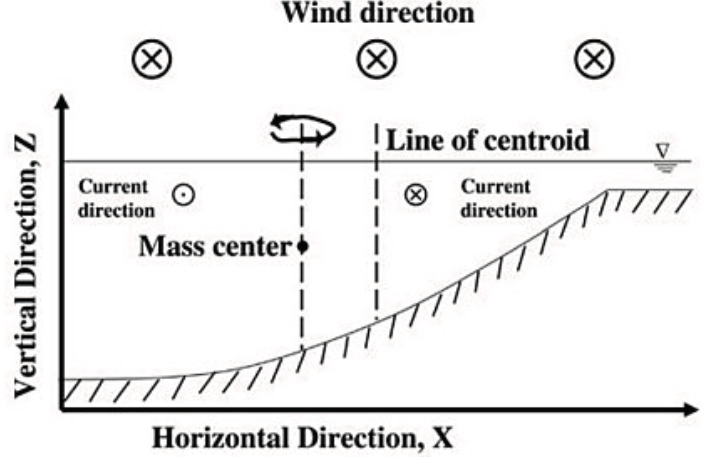
Figure 2. Schematic cross-section of wind-driven lake gyre circulation (A circle with an X represents wind or current going into the cross-section which a circle with a dot represents current coming out of the cross-section) (adapted from Ji and Jin [25] with permission from